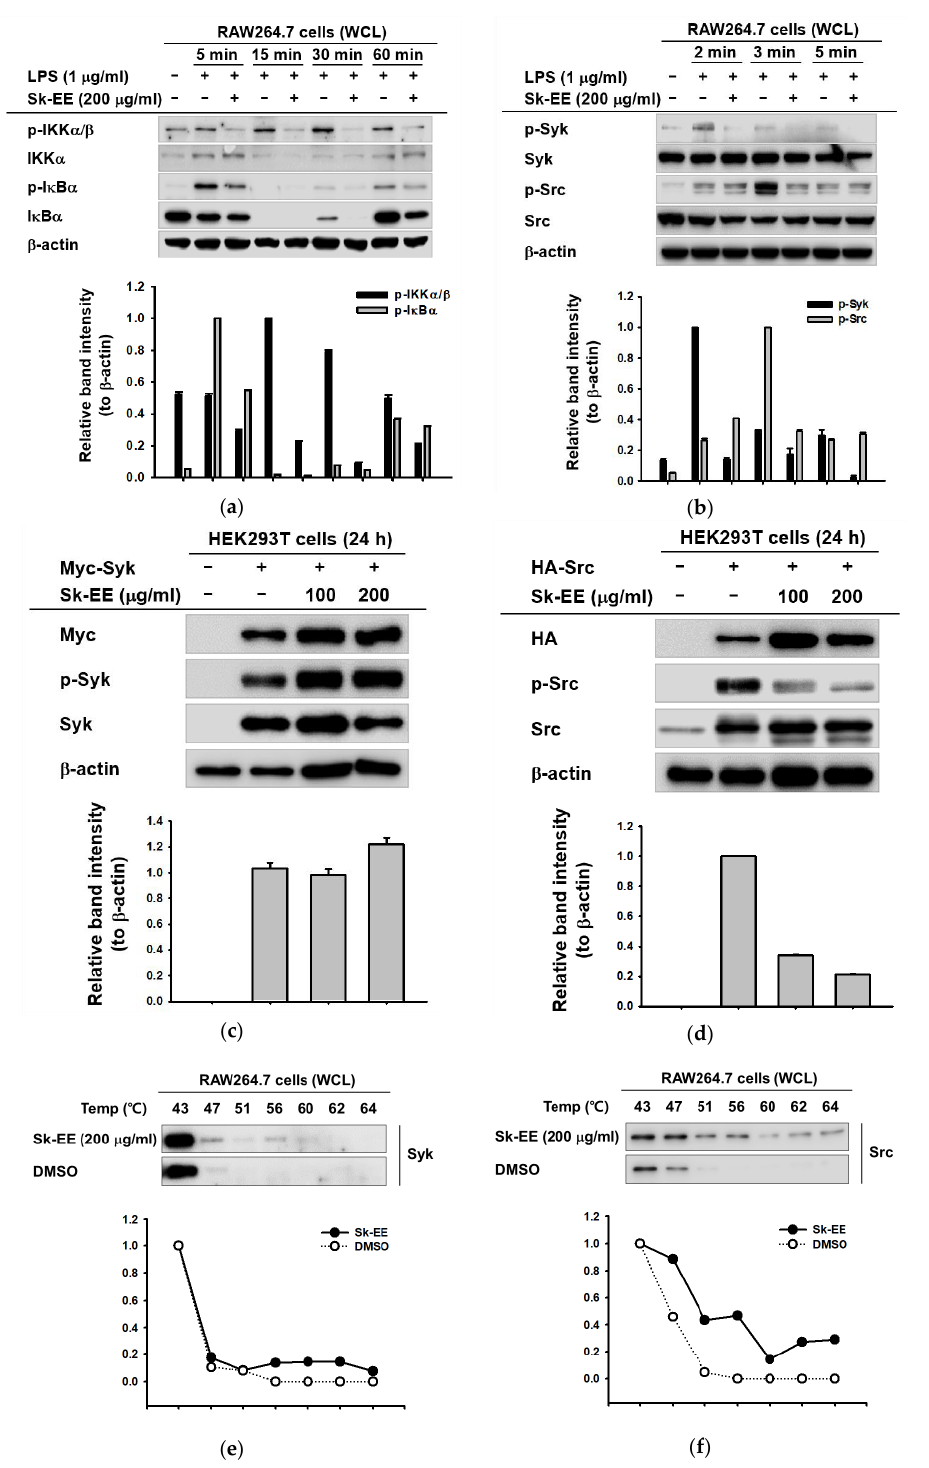
Figure 3. E ff ects of Sk-EE on the protein expression of the NF- κ B signaling pathway and target proteins. ( a , b ) RAW264.7 cells were pretreated with Sk-EE (200 µ g / mL) and induced by LPS (1 µ g / mL) for the indicated time. The expression levels of total or phosphorylated forms of IKK α / β , I κ B α , Syk, Src, and control protein β -actin were analyzed through western blotting. ( c , d ) HEK293T cells were transfected with Myc-Syc or HA-Src by PEI transfection for 24 h and treated with indicated doses of Sk-EE for 24 h. The protein expression levels of Myc, Syk, p-Syk, HA, Src, p-Src, and the control protein β -actin were analyzed by western blotting. ( e , f ) RAW264.7 cells were transfected